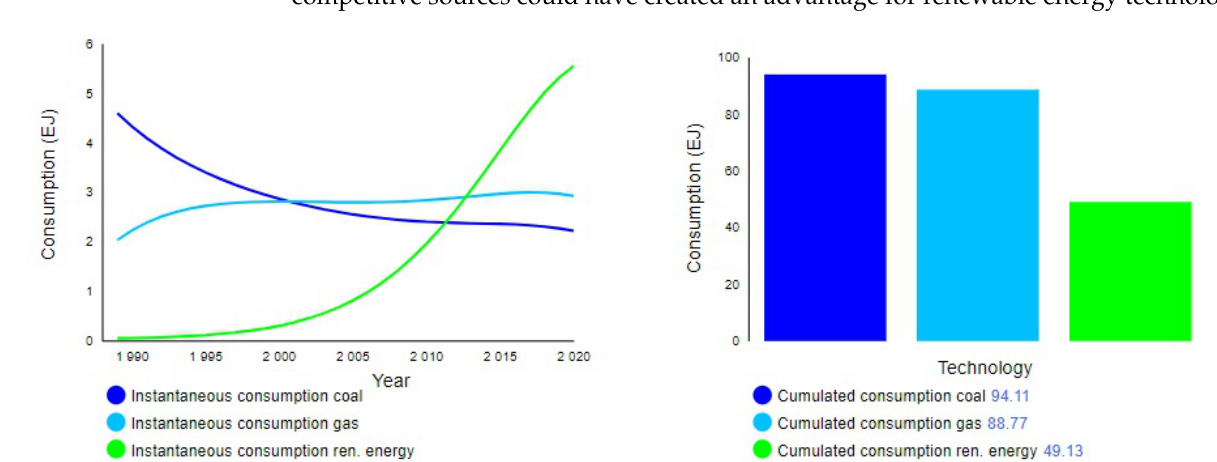
Figure 7. Simulation results of Policy